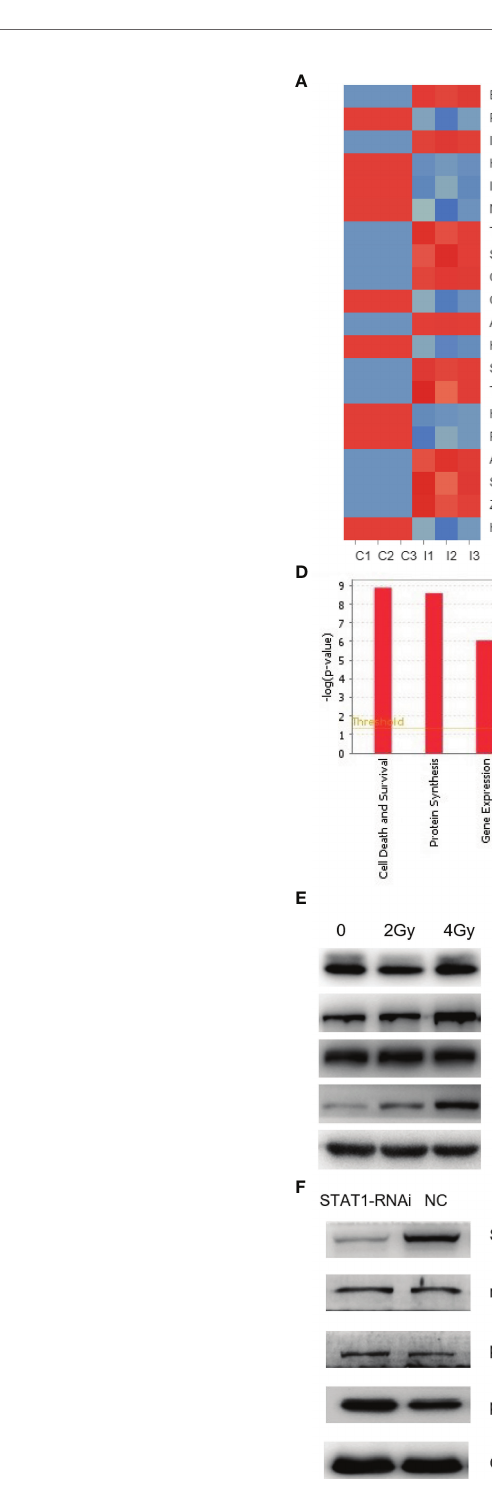
FIGURE 3 | 125 I-induced upregulation of the JAK/STAT1 pathway. (A) Heat map of differentially expressed proteins after treatment with 125 I in SMMC7721 cells. (B) Volcano plot of differentially expressed proteins in SMMC7721 cells. Green represents downregulated proteins and red upregulated proteins. (C) The expression level of STAT1 in iTRAQ assay. (D) Analysis results of disease and biofunctions of HCC cells. (E) Western blot of the JAK/STAT1 pathway. (F) Western blot analysis of AKT/ mTOR pathway. All experiments were performed in triplicate, and the data are presented as the mean ± SD. * P < 0.05, ** P < 0.01, *** P < 0.001. iTRAQ, isobaric tag for relative and absolute quanti fi cation labeling; HCC, hepatocellular carcinoma cells; EPI,